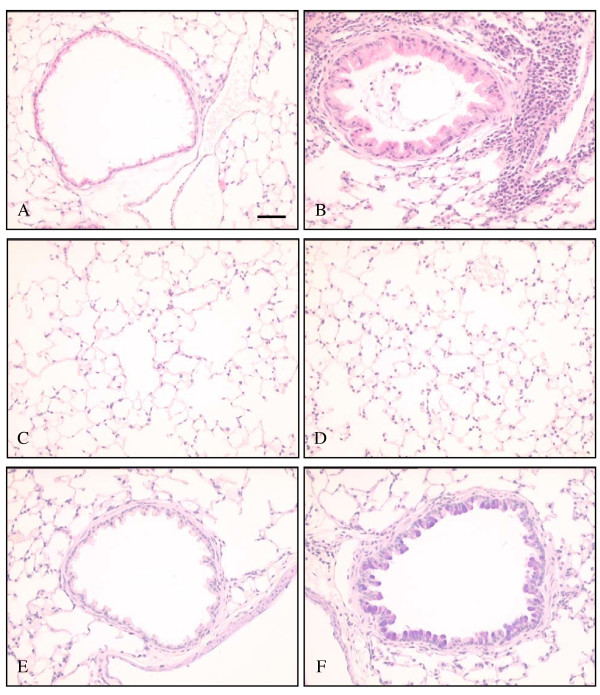
Histological appearance of murine lung 24 hours following final ovalbumin challenge. H&E staining of (A) saline sensitised/challenged and (B) ovalbumin sensitised/challenged airways at 24 hours after final challenge. Control airways did not show any inflammatory cell infiltration. A mixed inflammatory cell infiltrate can be seen around ovalbumin sensitised/challenged airways, particularly in those adjacent to blood vessels where margination and diapedesis of cells are seen. H&E staining of typical areas of parenchyma from (C) saline sensitised/challenged and (D) ovalbumin sensitised/challenged mice are similar, demonstrating the lack of interstitial inflammation produced by this model. PAS/Alcian Blue staining of (E) saline sensitised/challenged and (F) ovalbumin sensitised/challenged airways at 24 hours after final challenge. Most of the epithelial cells are replaced by blue/purple staining goblet cells in ovalbumin sensitised/challenged airways. Scale bar represents 50 μm.